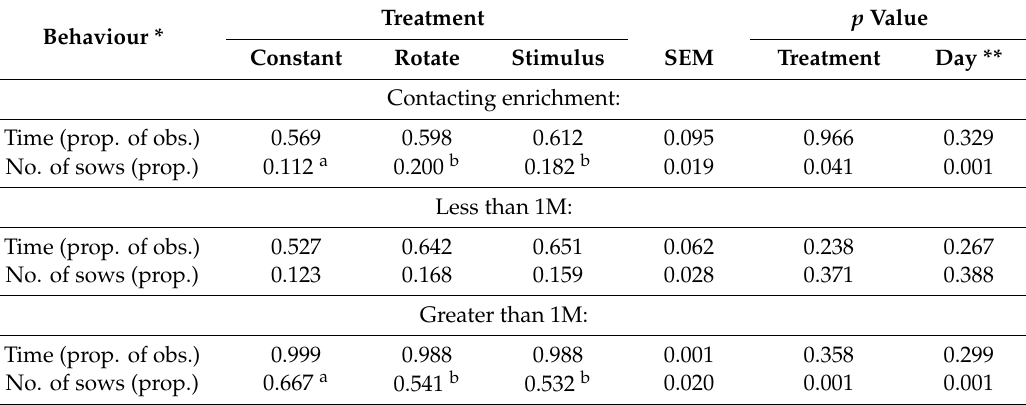
Table 2. E ff ects of enrichment treatment and day of observation on time spent (proportion of observations) and number of sows (proportion of sows) in contact with enrichment, less than 1 m or greater than 1 m from enrichment. Treatment p Value Behaviour * Constant Rotate Stimulus SEM Treatment Day ** Contacting